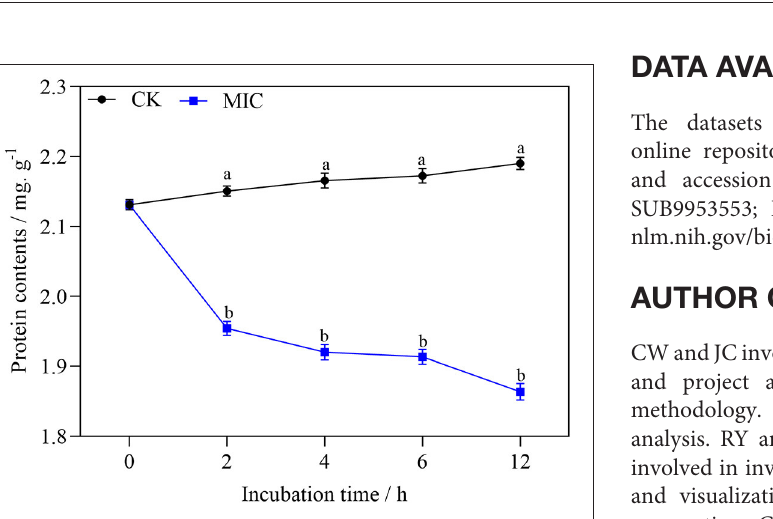
FIGURE 11 | The protein content of P. digitatum treated without or with MIC nanoemulsion at different incubation times. Values are the mean ± standard deviation (SD) ( n = 3), and the different letters indicate significant differences ( P <